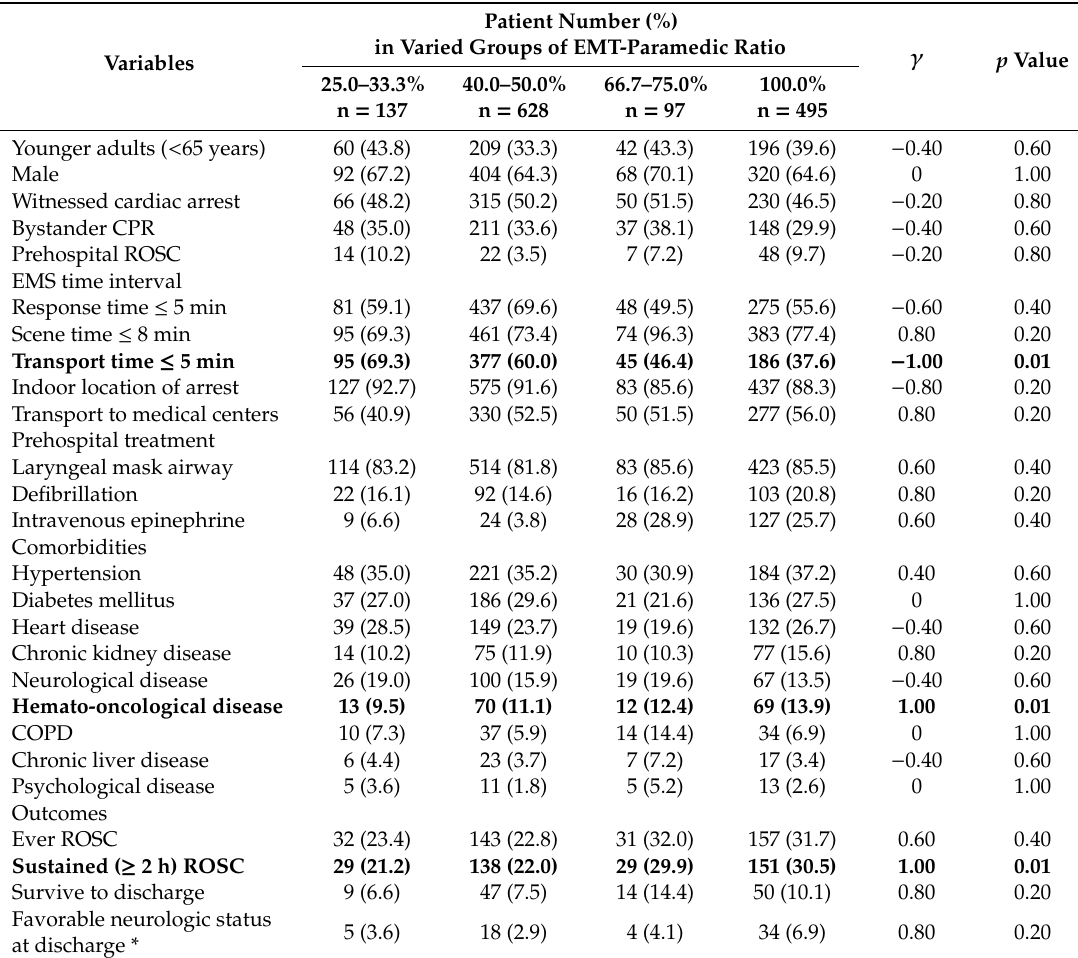
Table 1 reveals the trends of patient demographics, EMS time interval and prehospital treatment as the EMT-P ratio increased. There were no significant di ff erences among the 4 groups regarding patient characteristics, witness of cardiac arrest, bystander CPR, or prehospital management, such as laryngeal mask airway use, defibrillation, and intravenous epinephrine (all p ≥ 0.05). A negative ratio-related trend in EMS transport time of ≤ 5 min ( γ = − 1.00, p = 0.01) and a positive ratio-related trend in comorbid hemato-oncological disease ( γ = 1.00, p = 0.01) were seen. A positive ratio-related trend in the achievement of a sustained ROSC ( γ = 1.00, p = 0.01) was exhibited (Figure 2). Table 1. Demographic data and outcomes of enrolled out-of-hospital cardiac arrest patients stratified by the EMT-paramedic